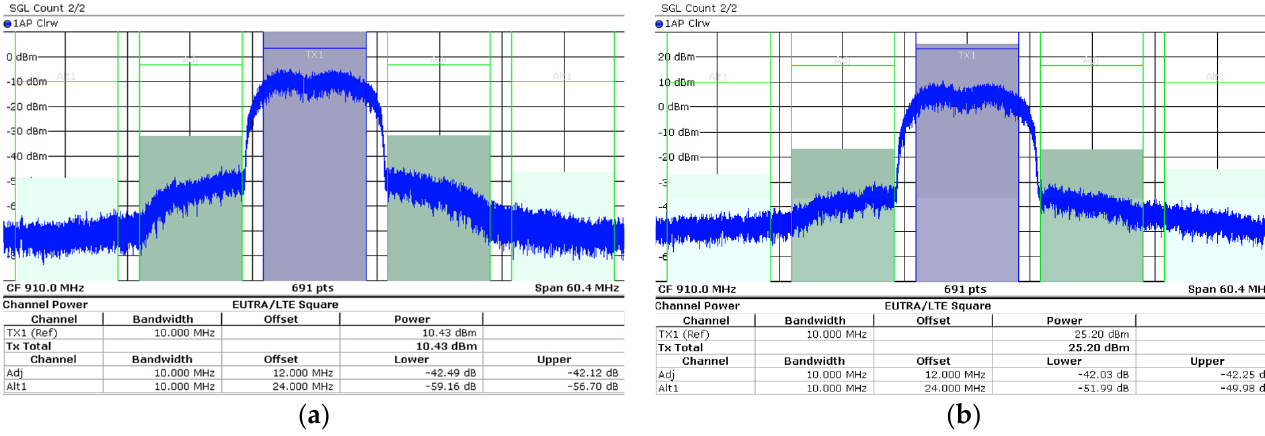
Figure 17 . Measured PA output spectrum for the OFDM 64-QAM signal with a bandwidth of 10 MHz at 0.91 GHz: ( a ) output power of 10.4 dBm in the LP mode, ( b ) output power of 25.2 dBm in HP mode. Table 1. Performance comparison of PAs with power-combining transformers on a PCB.